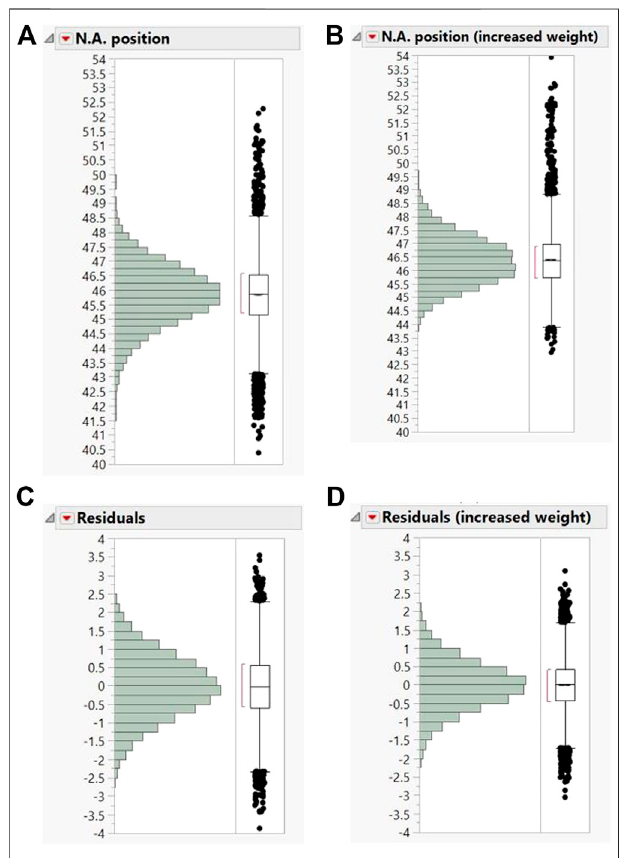
FIGURE 11 | (A) N.A. position for regular trucks weights vs (B) N.A. position for increased truck weights, (C) Residuals from method for regular truck weights vs (D) Residuals from method for increased truck